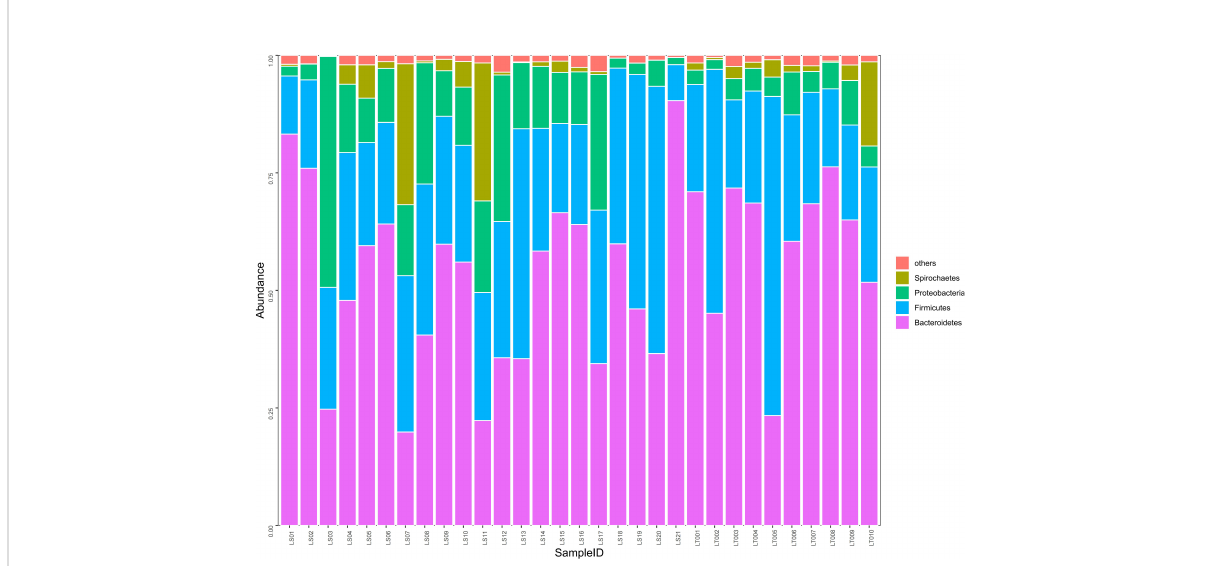
FIGURE 4 Comparison on the distributions of intestinal micro fl ora at the phylum level in two groups of rats. Fecal samples from the preterm rats at day 30 after birth were subjected to 16S rRNA sequencing. The relative abundances of intestinal micro fl ora including Bacteroidetes , Firmicutes , Proteobacteria , and Spirochaetes were summarized in the bar graph. The abscissa represents all the individual samples, and the ordinate represents the relative abundance of each phylum. LT001 – LT010, the normal control group; LS1 – LS21, the cognitive impairment group.